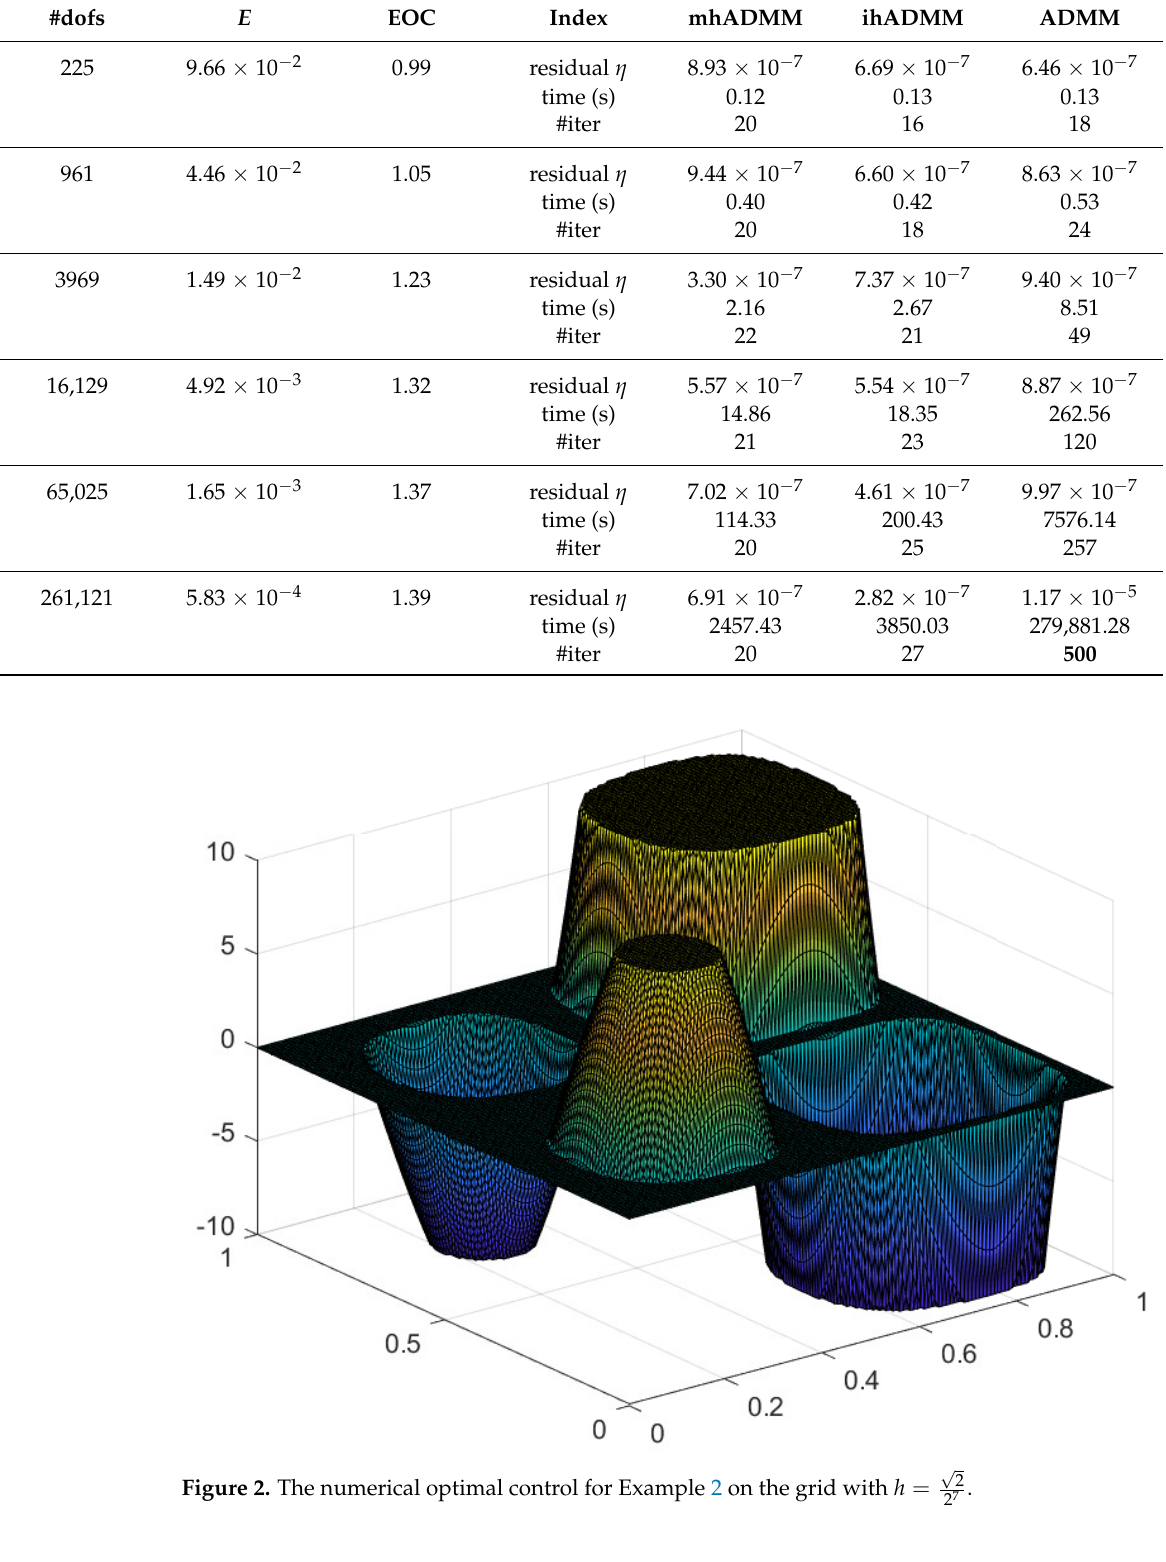
Figure 2. The numerical optimal control for Example 2 on the grid with h =